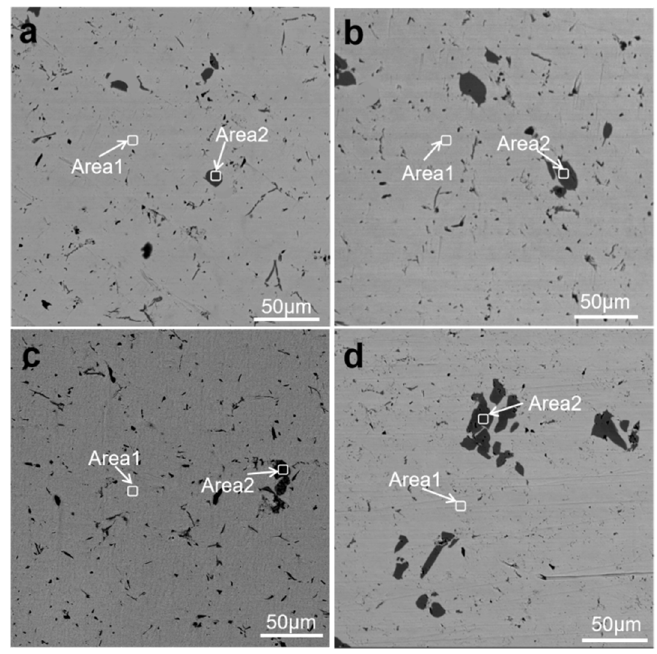
Figure 8. The SEM-BSE images of Ti-30Mo-0.5TiC-xZr alloys: ( a ) T0, ( b ) T4Z, ( c ) T8Z, and ( d ) T12Z.